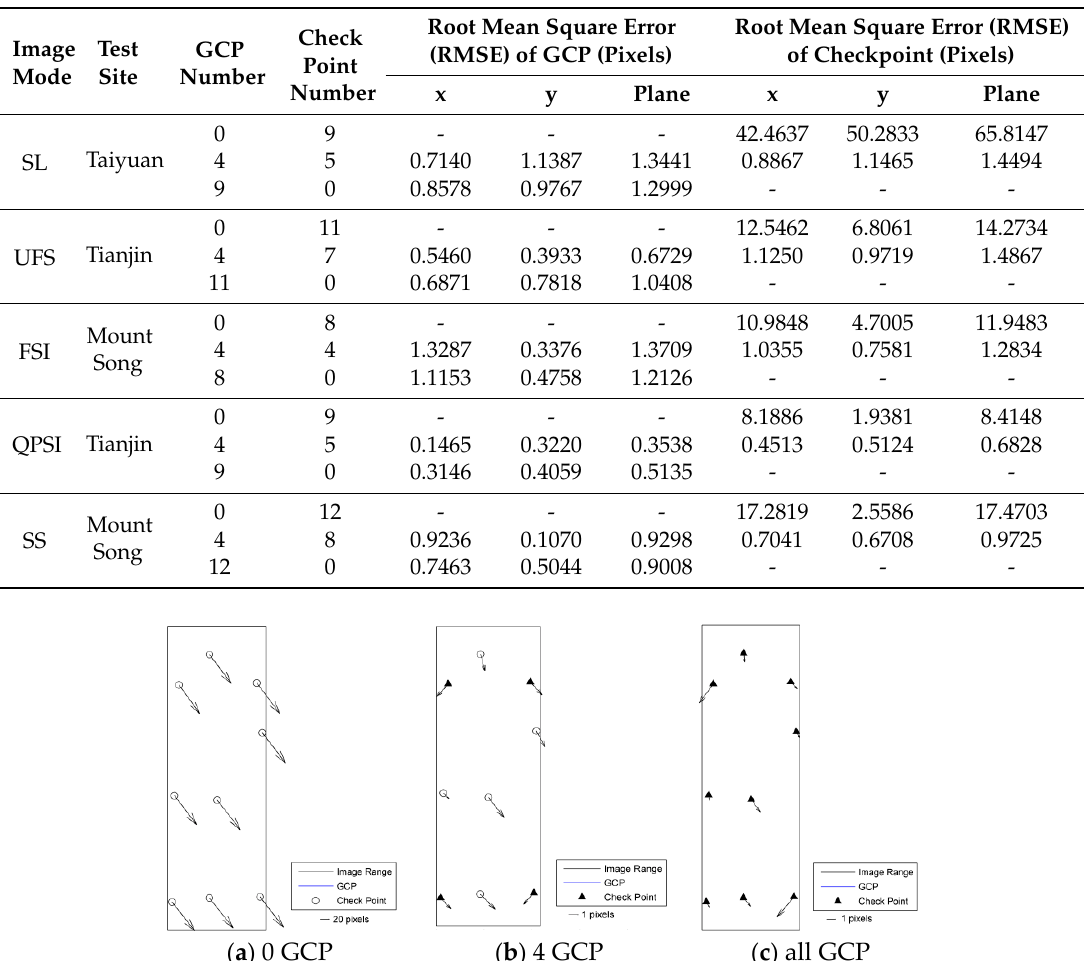
Table 3. Single image orientation accuracy of five GF-3 satellite image modes (pixel).